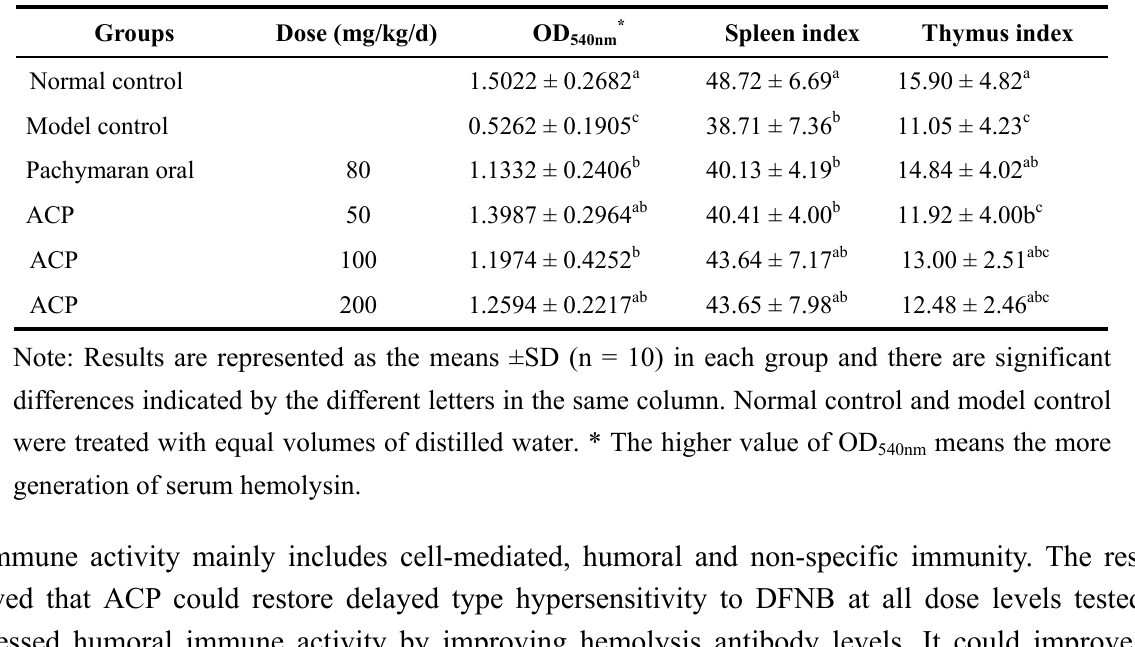
Table 5. Effects of alkaline soluble polysaccharides on the generation of serum hemolysin, the thymus and spleen index in mice ( ± SD). Groups Dose (mg/kg/d) OD 540nm* Spleen index Thymus index Normal control 1.5022 ± 0.2682 a 48.72 ± 6.69 a 15.90 ± 4.82 a Model control 0.5262 ± 0.1905 c 38.71 ± 7.36 b 11.05 ± 4.23 c Pachymaran oral 80 1.1332 ± 0.2406 b 1.3987 ± 0.2964 ab